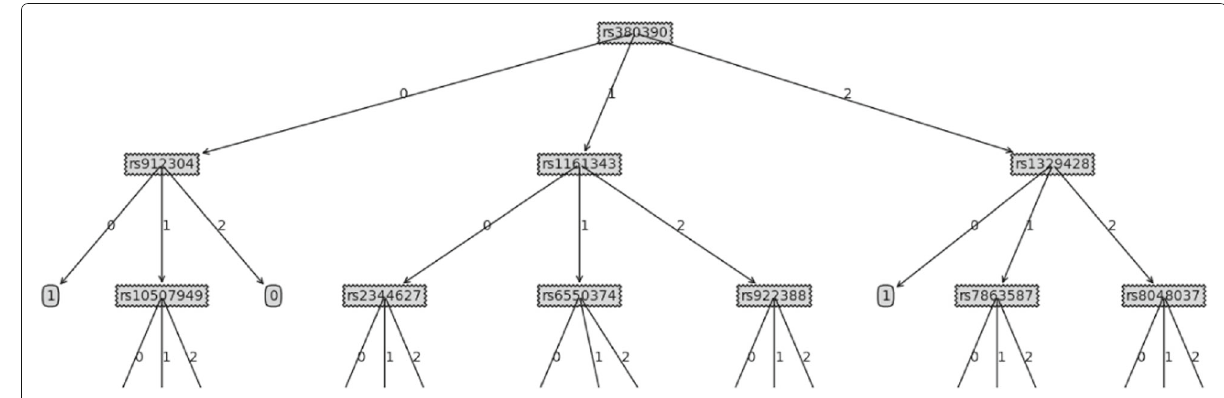
Fig. 8 Epistasis results on the dataset AMD